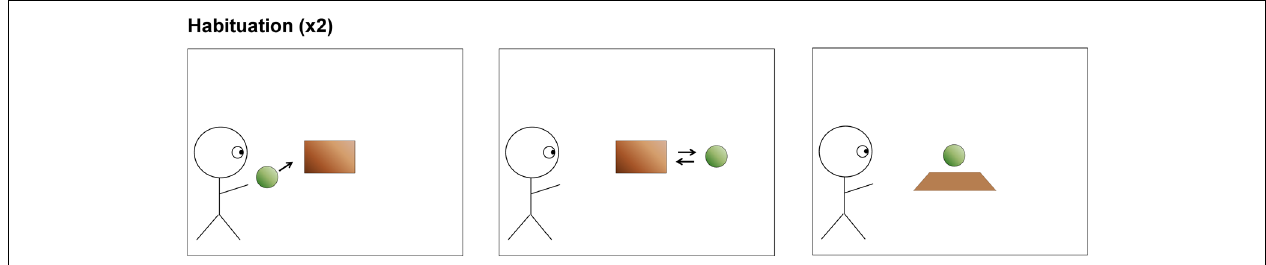
FIGURE 1 | Infants were habituated to a movie with the depicted structure. The ball is thrown so that it passes and then hides behind the occluding wall and is subsequently revealed, all in the agent’s presence. Each infant was shown this animation twice (Kovács etal., 2010, supporting online material).